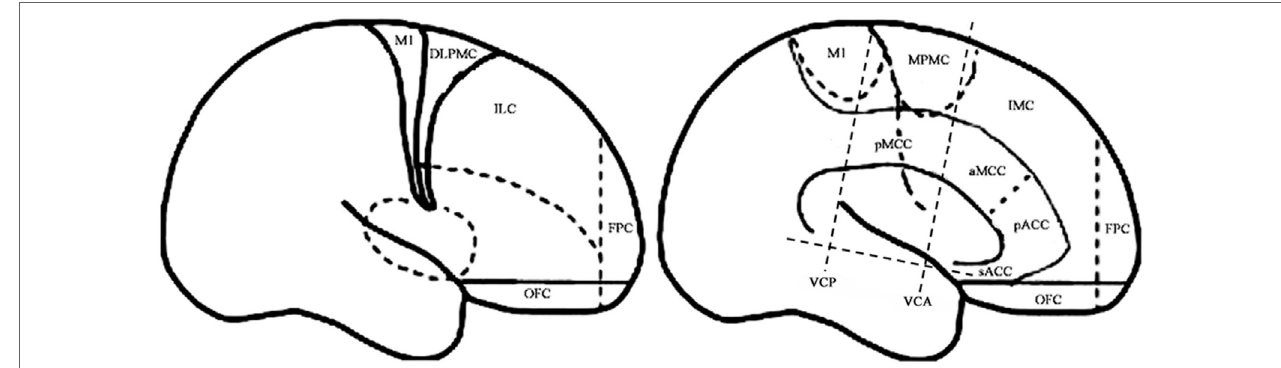
FigUre 1 | Schematic anatomical division of the frontal lobe used for description in the present study [modified from Bancaud and Talairach (14) and Rheims et al. (2)]. M1, primary motor cortex; DLPMC, dorsolateral premotor cortex; FPC, frontopolar cortex; ILC, intermediate dorsolateral frontal cortex; IMC, intermediate mesial cortex; MPMC, mesial premotor cortex; OFC, orbitofrontal cortex; sACC, subgenual anterior cingulate cortex; pACC, pregenual anterior cingulate cortex; aMCC, anterior middle cingulate cortex; pMCC, posterior middle cingulate cortex; VCA, vertical commissure anterior; VCP, vertical commissure